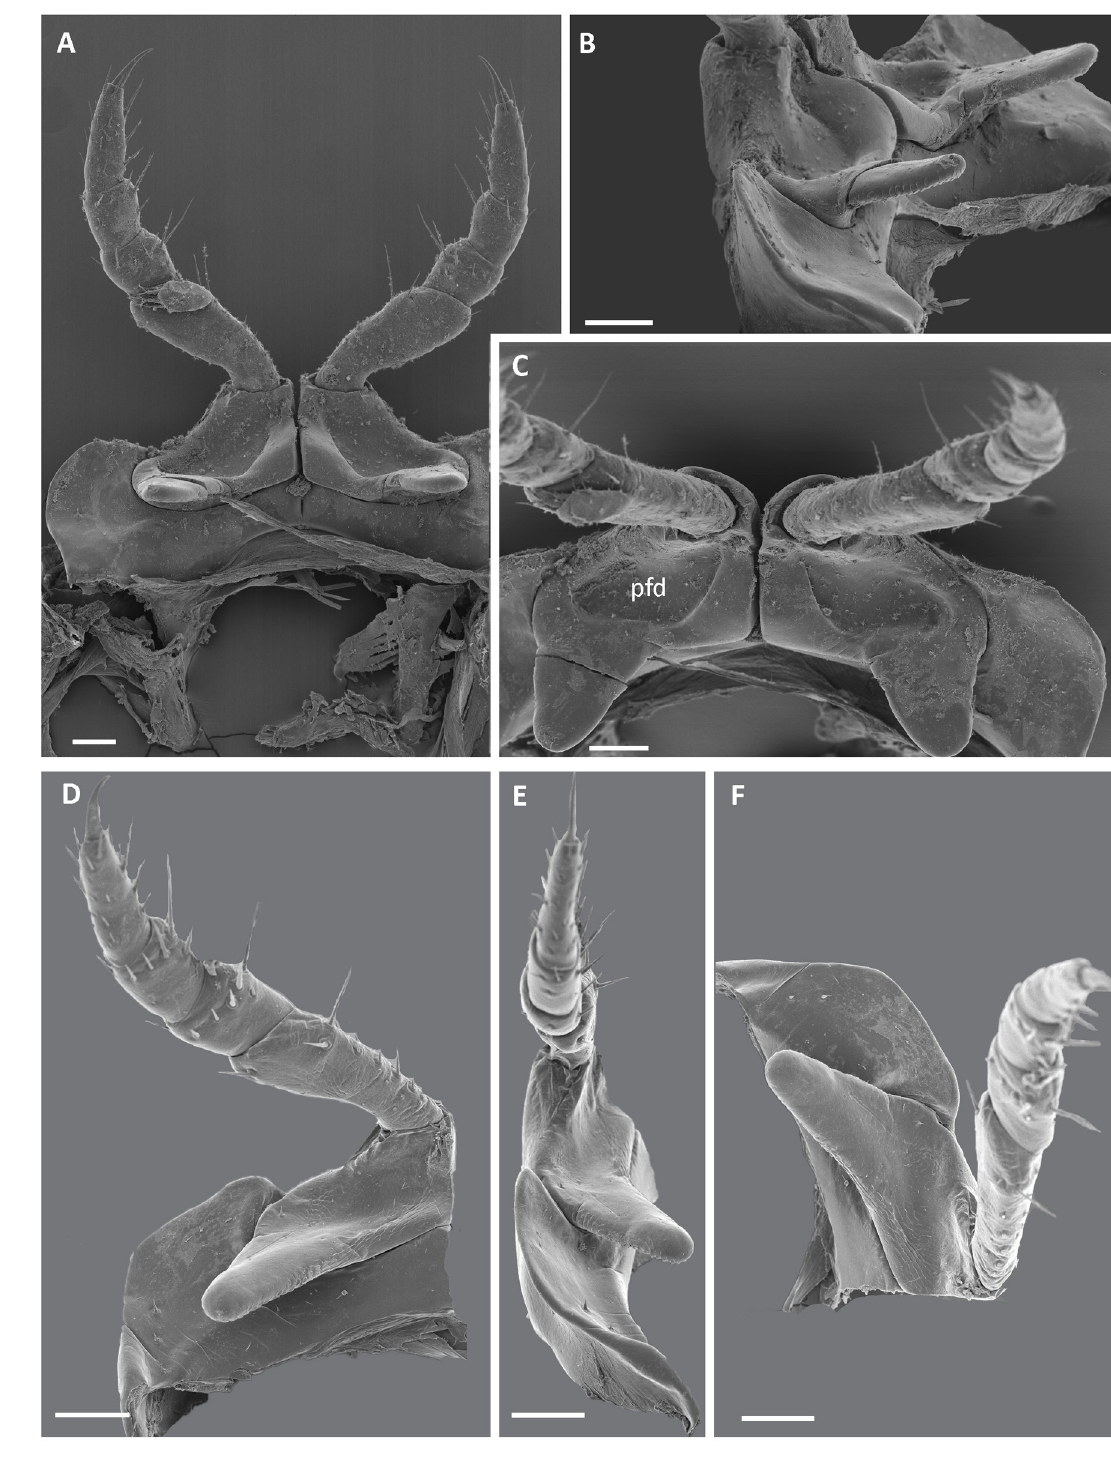
Fig. 4 . A – C . Aquattuor nguruensis sp. nov., holotype, ♂ (VMNH110617), first pair of legs. Notice mite larva (”hypopus”) on left femur. D – F . A. denticulatus Frederiksen, 2013, paratype, ♂ (NHMD 621640), left leg of first pair. A, D . Anterior view. B, E . Sublateral view. C, F . Sub-ventral view. Abbreviation: pfd = prefemoral depression. Scale bars = 0.1